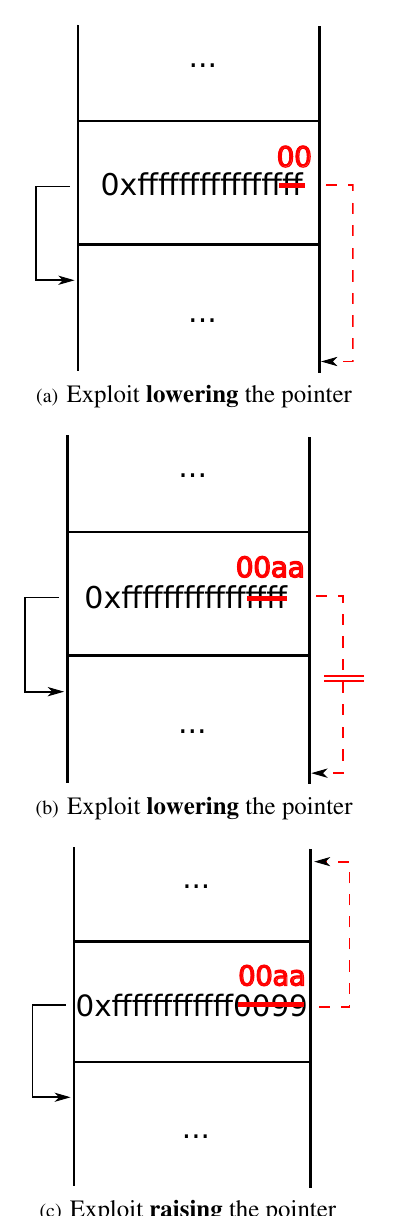
Figure 9. Exemplary results of pointer modifications using strcpy to alter at most two least-significant bytes.